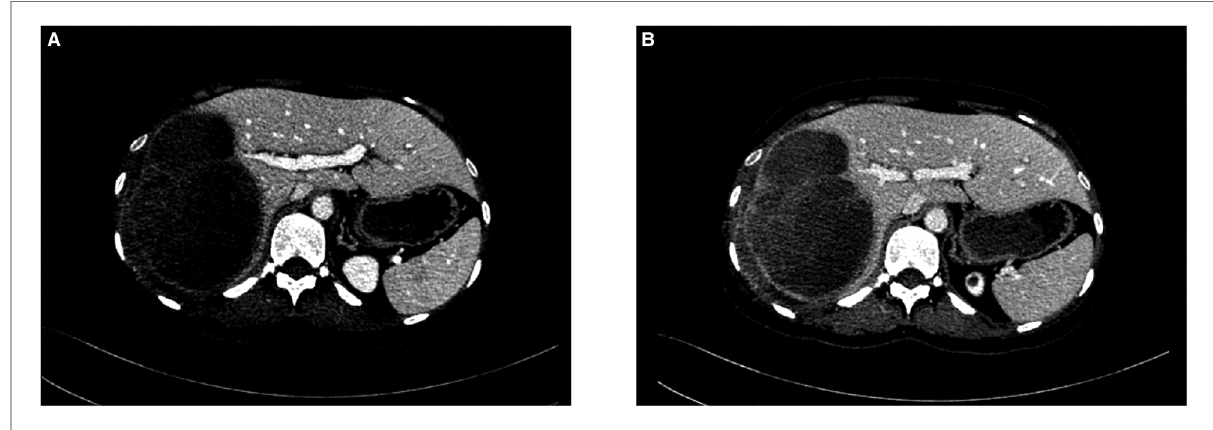
FIGURE 1 Preoperative abdominal CT fi ndings ( A ) arterial phase ( B ) venous